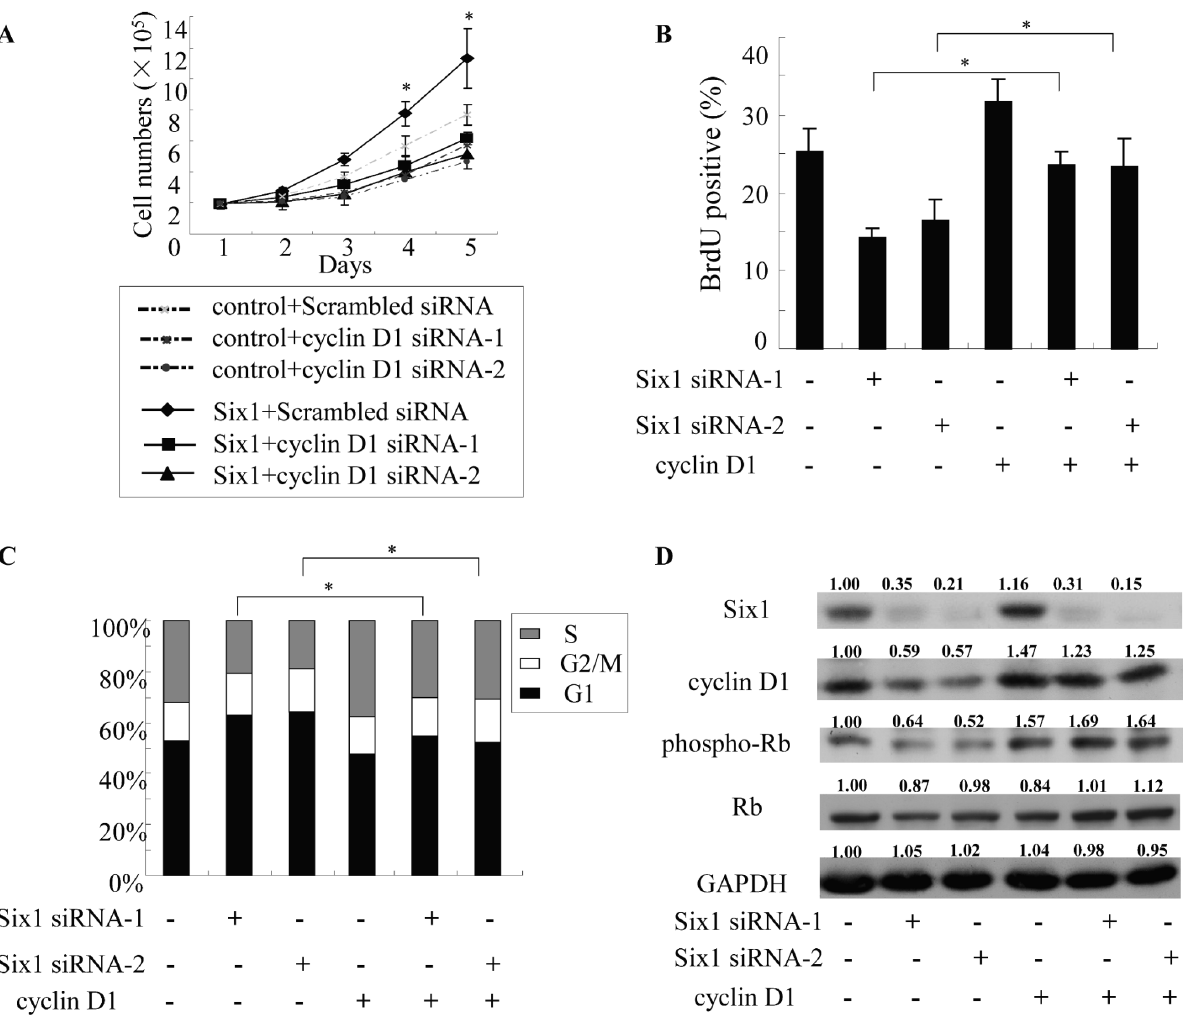
Figure 5. Six1 regulates pancreatic cancer cell growth and cell cycle progression through cyclin D1. A, Knockdown of cyclin D1 decreases proliferation of PANC-1 cells transduced with Six1. B, C, and D, overexpression of cyclin D1 rescued the inhibitory effect of Six1 silencing on the growth of PANC-1 cells, which was examined by BrdU incorporation assay (B) and flow cytometry analyses (C). The phosphorylation levels Rb (phospho-Rb) was also examined by western blot analyses. The expression of proteins was quantified using the expression of GAPDH as calibrator and normalized against the control group value (D). All the experiments were performed in triplicate; bars, s.e.m.; * P , 0.05.